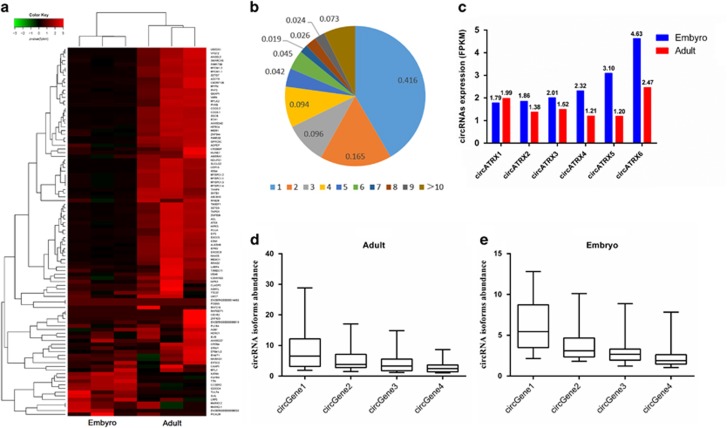
Characteristics of circular RNA in bovine skeletal muscle. (a) Clustered heat map showing abundances of the corresponding linear host transcripts of the top 100 most differentially expressed circRNAs. (b) Numbers of circRNAs produced by the same gene. (c) Exemple of circATRX, which showed six alternative circRNA isoforms. (d, e) Box plots showing abundances of differentially expressed circRNA isoforms. The first four circRNAs are presented